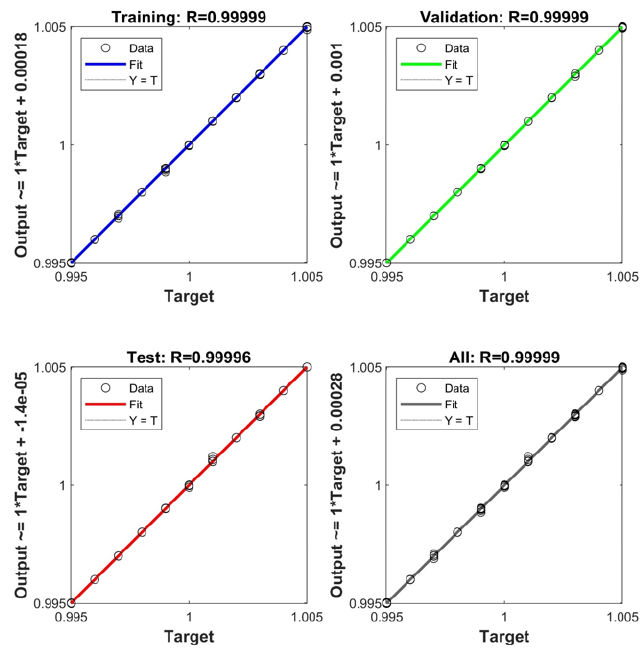
Figure 21. Neural network regression and function fitting of the ANN model.